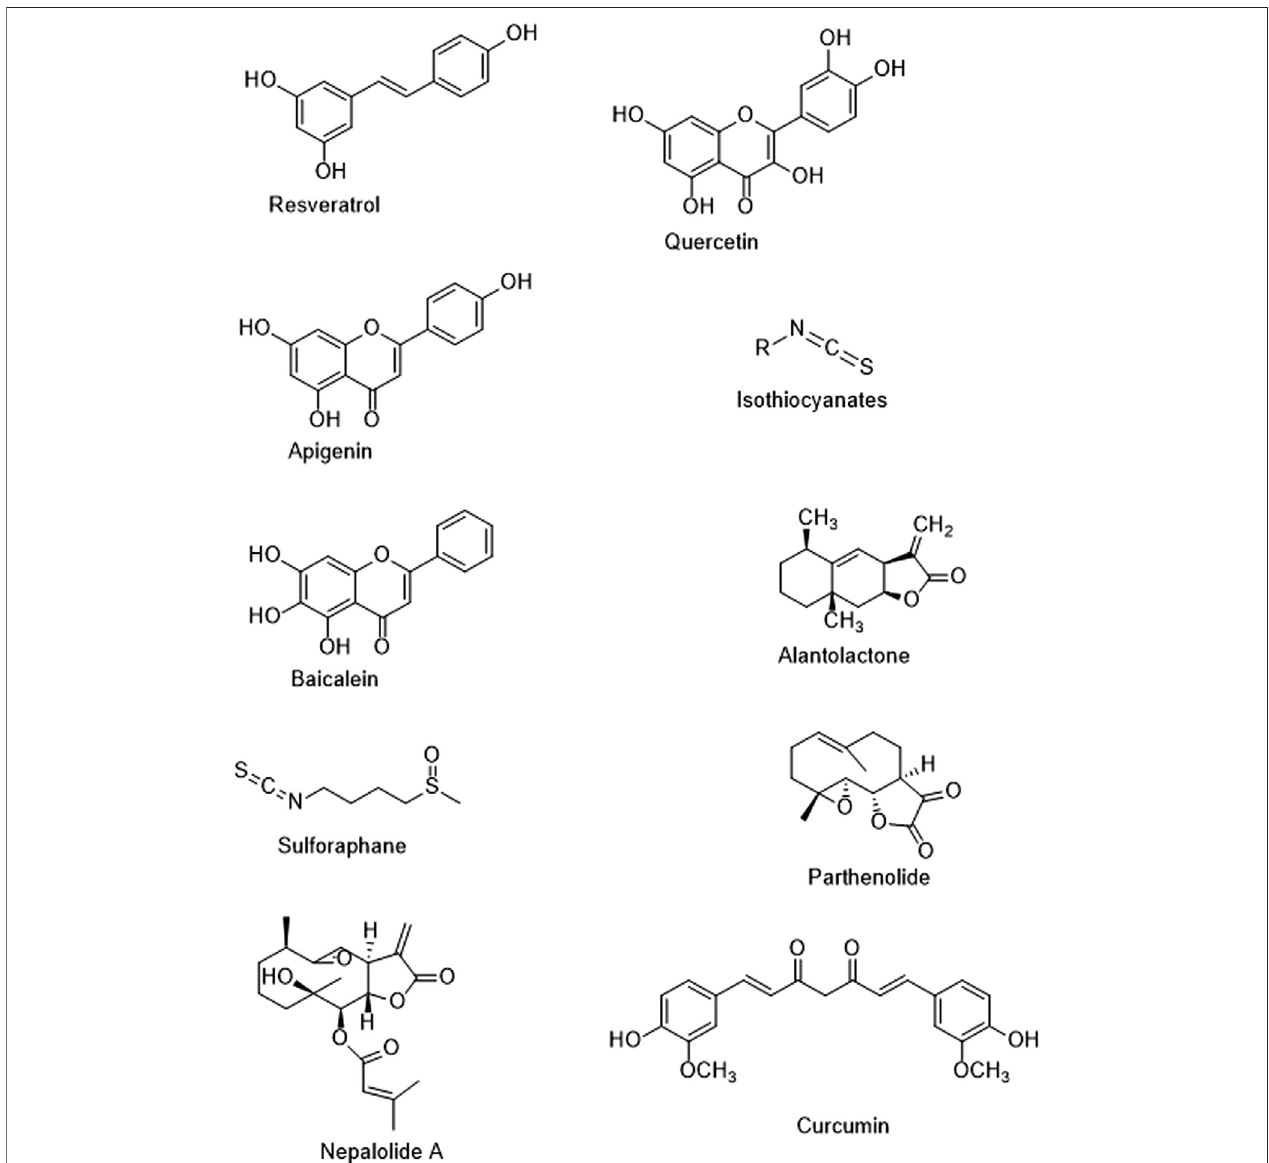
FIGURE 2 | Chemical structures of the discussed